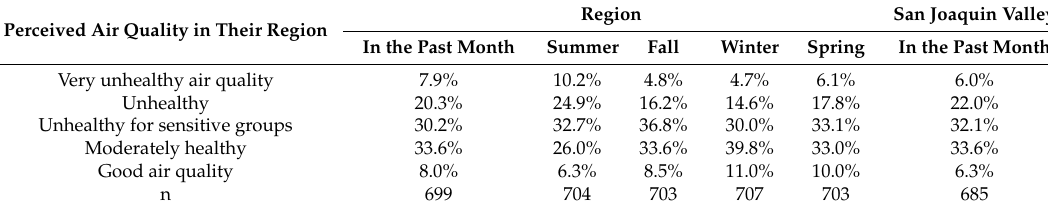
Table 2. Perceived air quality in their region.